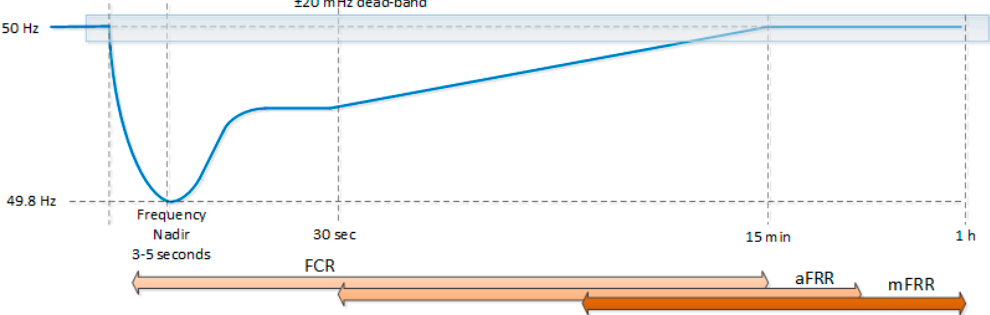
Figure 7. Generic frequency profile in normal operation due to a sudden increase in electrical demand.